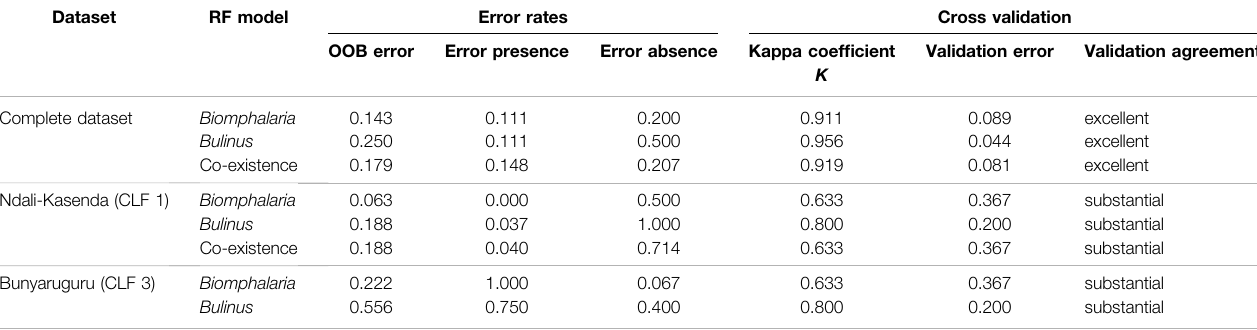
TABLE 2 | Error rates and results of cross validation for all runs of the random forest (RF) models. Validation agreement was evaluated in accordance with Viera and Garrett (2005). The co-existence model for CLF three had insuf fi cient data and is not included here. OOB, out-of-bag error.